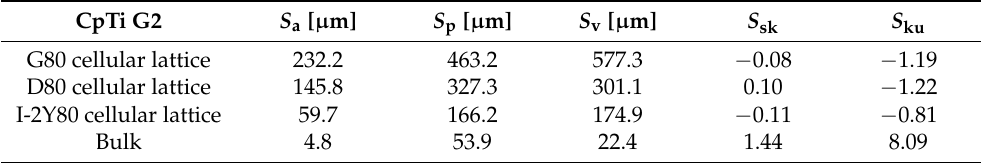
Figure 6. Topography maps determined for the CpTi G2 produced by SLM: ( a ) G80 cellular lattice; ( b ) D80 cellular lattice; ( c ) I-2Y80 cellular lattice; ( d ) Bulk. Table 2. Statistical parameters obtained for the topography maps of the CpTi G2 produced by SLM; S a is the arithmetic mean deviation, S p is the maximum peak height, S v is the maximum valley depth, S sk is the skewness, and S ku is the excess kurtosis.